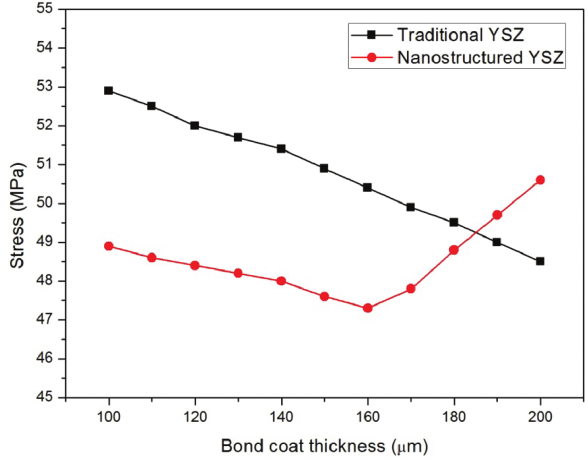
Figure 5: Axial tensile stresses in traditional and nanostructured YSZ coatings as a function of bond coat